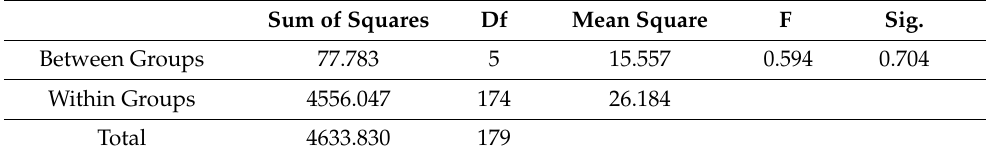
Table 18. One-way ANOVA test on the 1000-PHEV dataset. Sum of Squares Df Mean Square F Sig. Between Groups 77.783 Within Groups 174